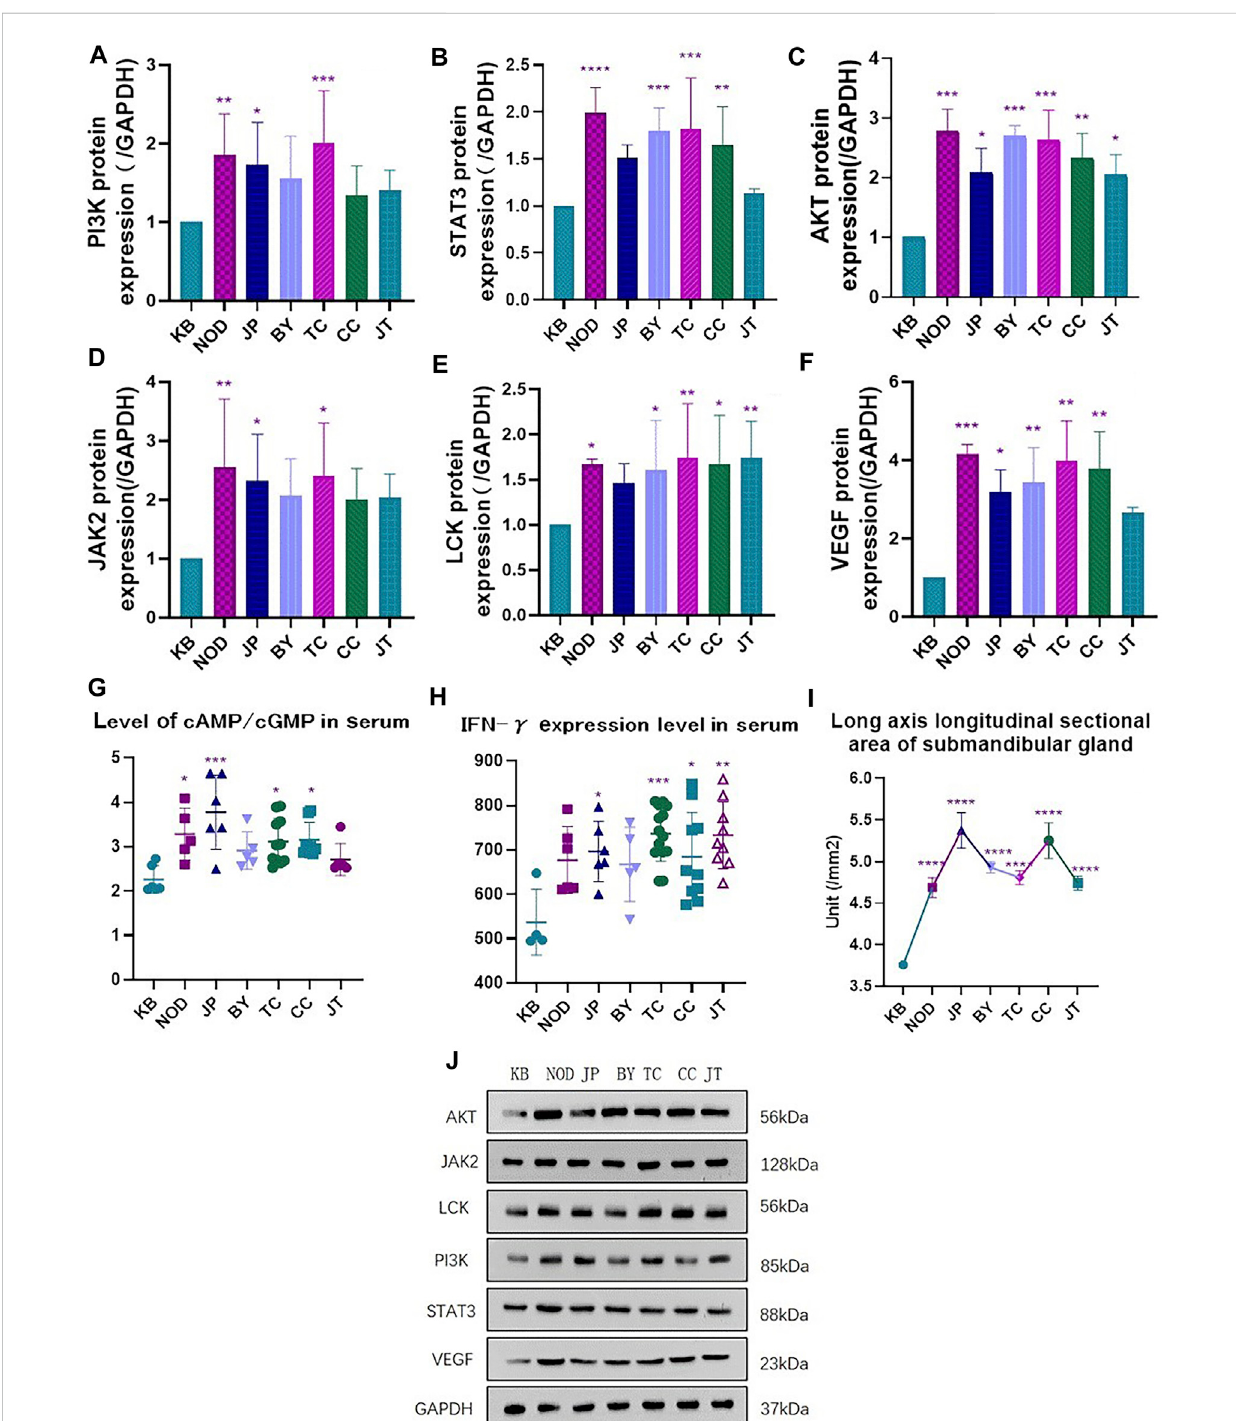
FIGURE 5 (A) Expression of PI3K protein. (B) Expression of STAT3 protein (C) Expression of AKT protein. (D) Expression of JAK2 protein. (E) Expression of LCK protein. (F) ExpressionofVEGFprotein. (G) LevelofcAmp/cGmpexpressioninmiceserum. (H) Expressionofin fl ammatoryfactorsIFN- γ inmiceserum. (I) Longitudinal sectional area of submandibular gland long axis in each group. (J) Western blotting.* p < 0.05, ** p < 0.01 vs. control group